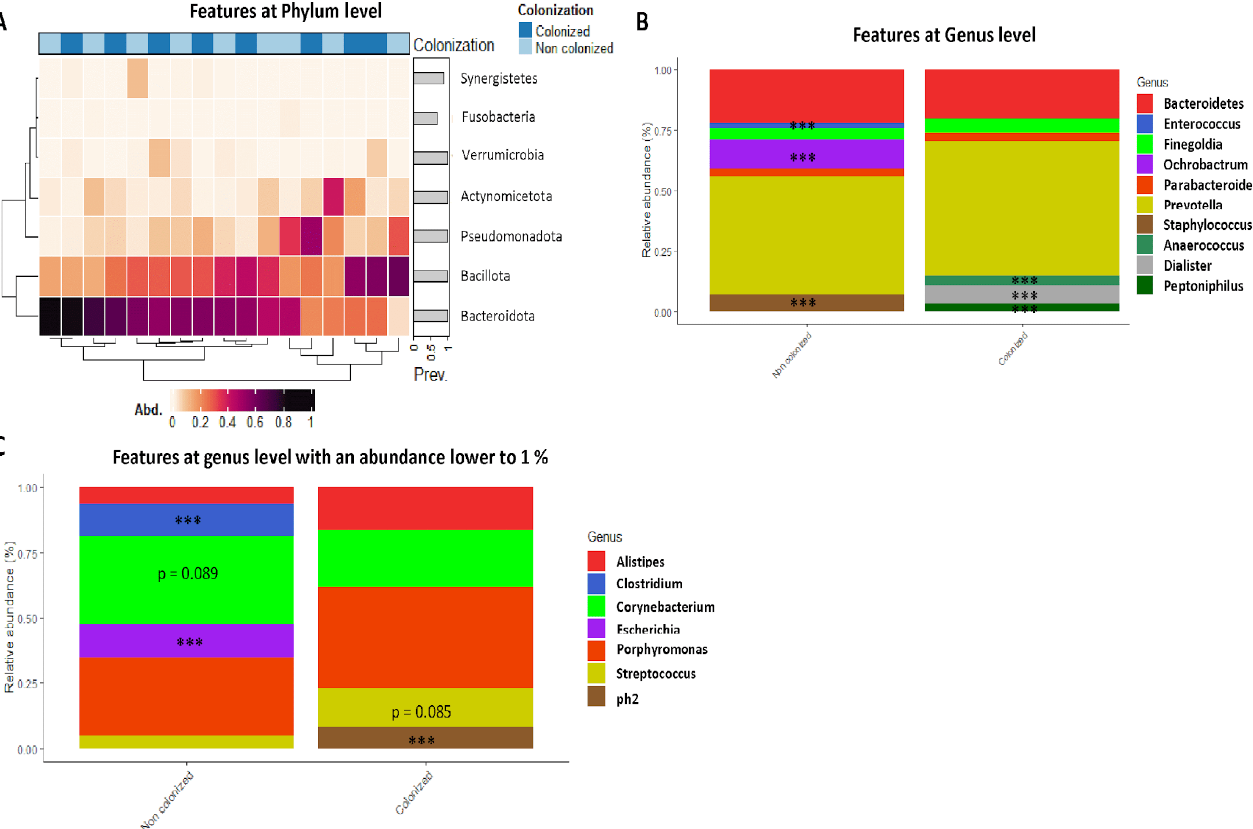
Figure 2. Non-colonized and colonized patients presented differences in some taxa composition at Genus level. ( A ) Heatmap representation of taxa differences based on Phylum annotation. ( B ) Taxa differences at Genus levels for features with an abundance higher than 1%. ( C ) Taxa differences at Genus levels for features with an abundance lower than 1%. Significant differences are represented as *** = p < 0.001. Statistical test employed was t-test for parametric distributions and Wilcoxon test for non-parametric distributions.